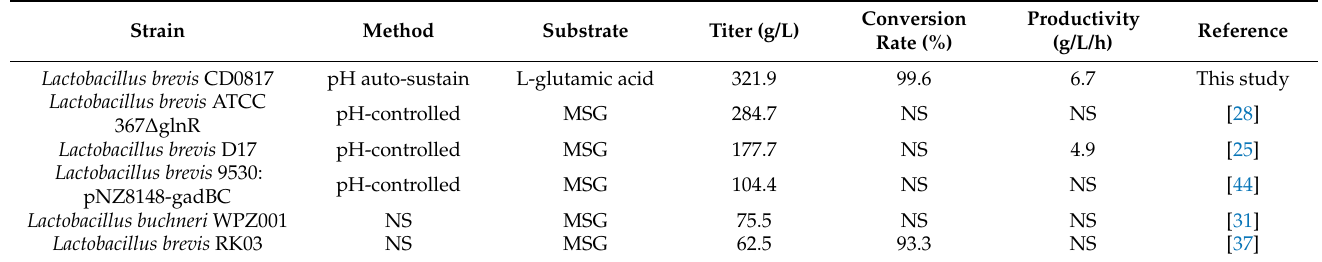
Table 1. Comparison of the effects of fermentation methods on gamma-aminobutyric acid production by lactic acid